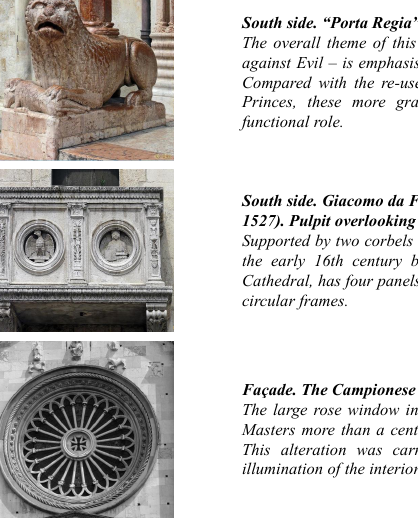
Figure 4. Some exemplar notes stored in the database of the architectural details of the Modena Cathedral.